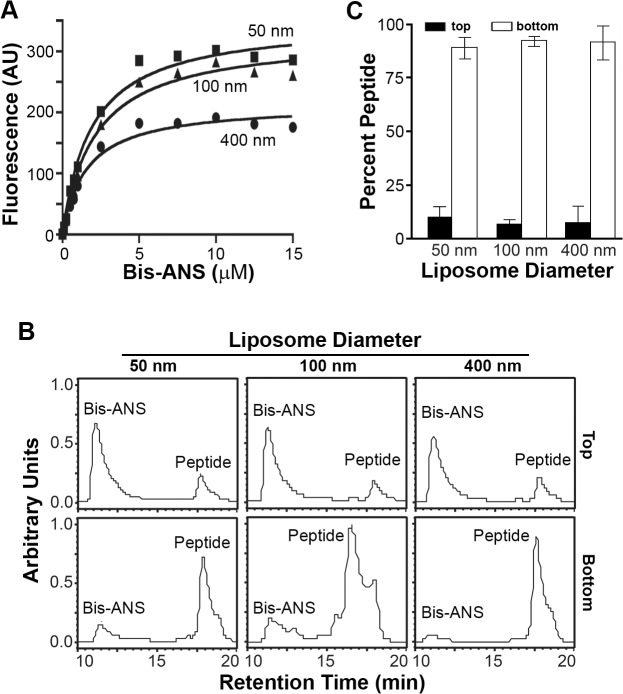
Partitioning of p15HPpep into liposomes is based on curvature-dependent hydrophobic defects.(A) Partitioning curves of bis-ANS in 100 mM suspensions of 50 nm, 100 nm, and 400 nm liposomes. bis-ANS fluorescence was fit to one-site binding hyperbola nonlinear regression using GraphPad Prism. Data points represent the mean of three experiments, with error bars contained within the symbols on the graph. (B) HPLC chromatograms in arbitrary units of absorbance at 215 nm of the top (liposomes) and bottom (free peptide) fractions from sucrose gradients following partitioning of wt p15HPpep into liposomes of the indicated diameter as described in Fig 4A, except liposomes were pre-treated with 10 mM bis-ANS before p15HPpep addition. Note that retention times of the wt p15HPpep differ from Fig 4 due to use of a different HPLC column. (C) As in panel B, quantifying percent p15HPpep associated with top (black bars) and bottom (white bars) sucrose fractions based on integrating the area under the chromatogram peaks. Results are mean SEM from three independent experiments.